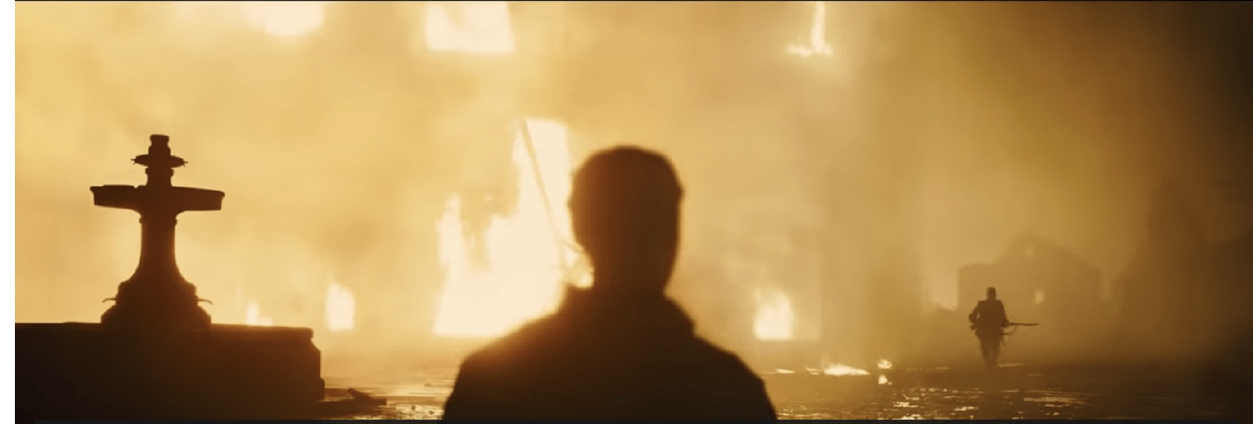
Figure 15. From out of the haze, we see another person emerge. (Screenshot created by author).